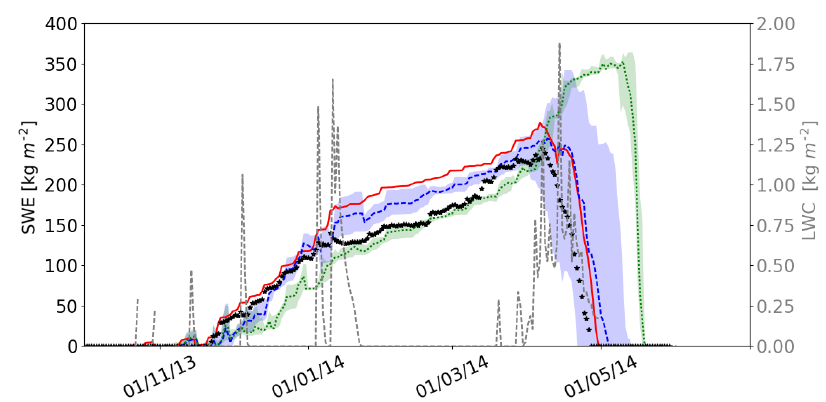
Figure 8. Evolutions of measured SWE (black points) for Site 3 from 2013 to 2014, original SWE Crocus simulation (red full line), and SWE DA obtained with a DA of the three frequencies applied for the entire winter (green dotted line) and when LWC = 0 only (blue full line). The simulated total liquid water content (LWC) in the snowpack (dotted gray lines) is also shown.